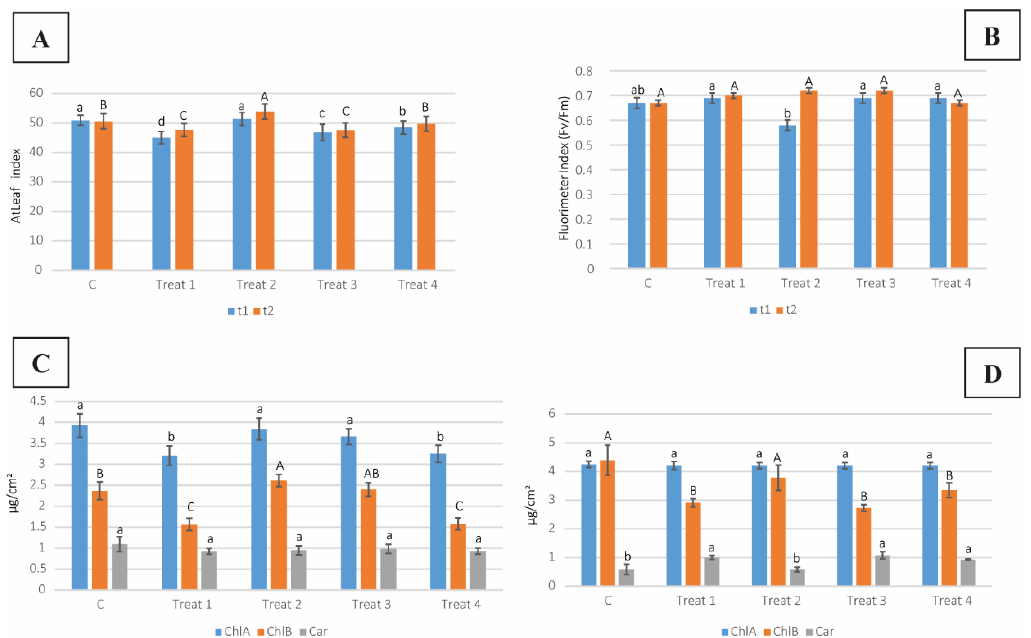
Figure 3. Measurements of chlorophyll contents using different instrumentation. ( A ) Chlorophyll measured with atLeaf; ( B ) measurements of photosynthetic efficiency using HandyPea photometer; ( C , D ) Measurements of chlorophyll a (ChlA)and b (ChlB) and carotenoids (Car) in t1 ( C ) and t2 ( D ) by spectrophotometer. Different letters indicate statistical differences at p < 0.05 with Tukey’s test; lowercase letters are used for t1 results and capital letters are used for t2 results.